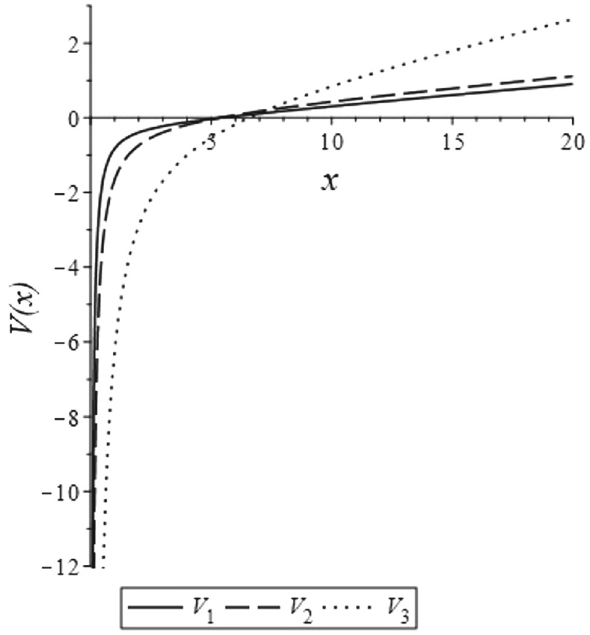
Fig. 1 The behavior of the potential Eq. (7), Cornell potentials V 2 ( x ) of Ref. [21] and V 3 ( x ) of Ref. [18] V 1 ( x ) = − c F α s α 2 c F n f s log (γμ x ) + c F n f x 3 π 0 . 03 x , V 3 ( x ) = − 6 . 39